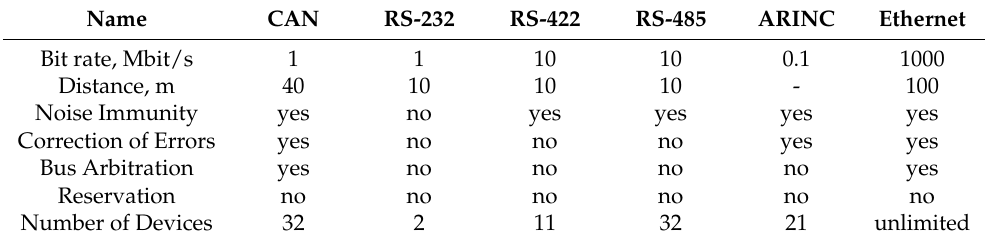
Table 1. Technical characteristics of the data exchange